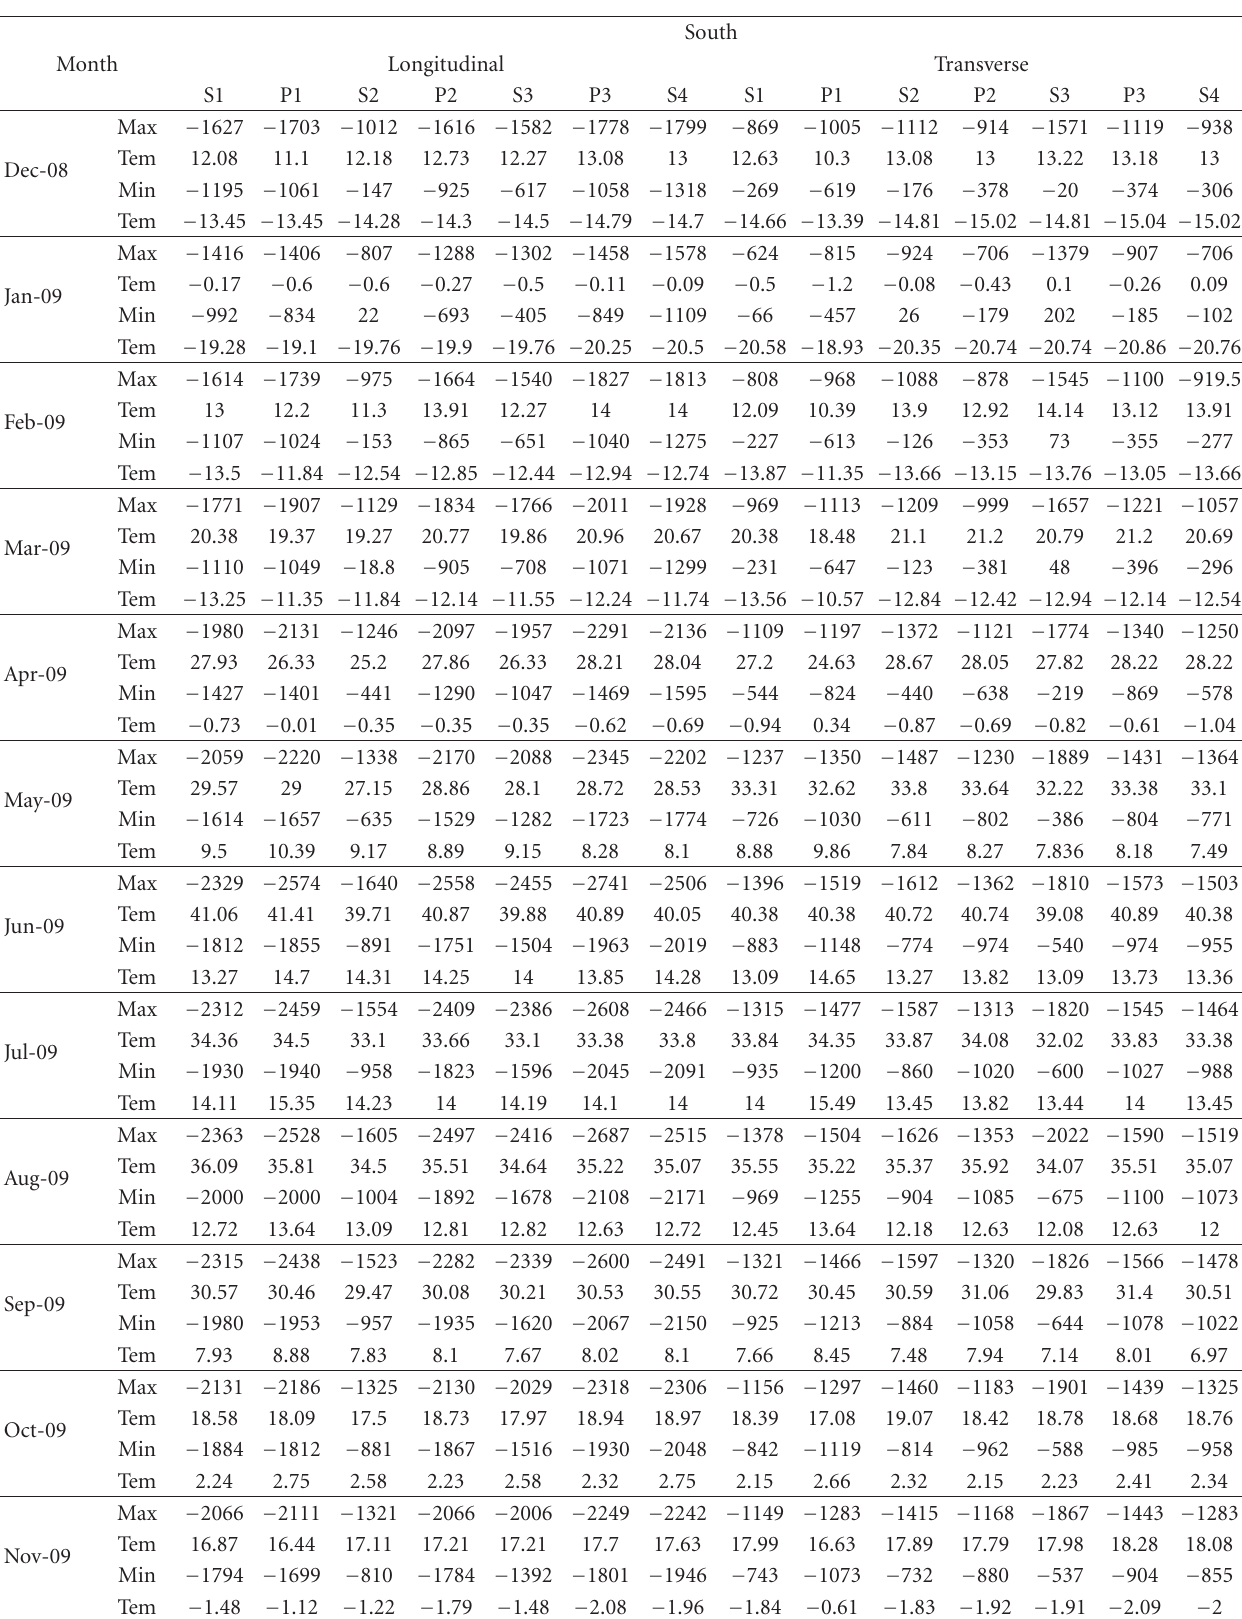
Table 7: Maximum and minimum stresses—south (psi) ∗